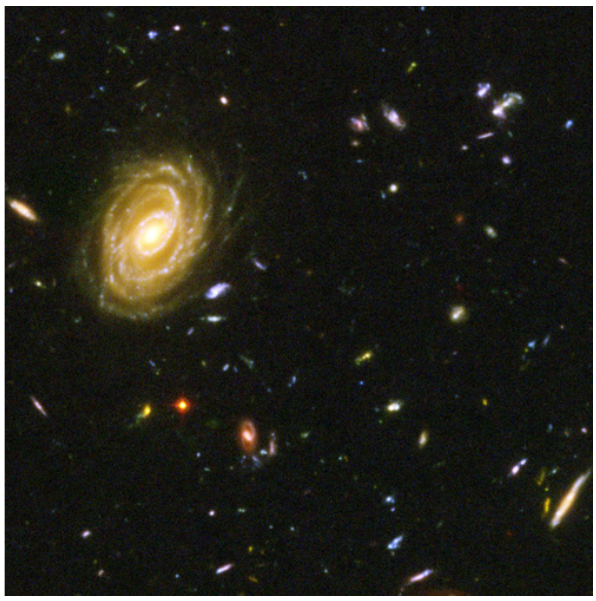
Figure 9. Hubble Space Telescope broad field image showing nu- merous